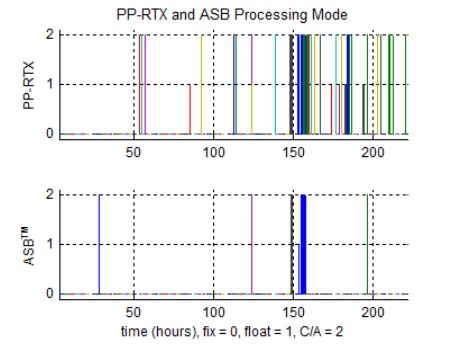
Figure 4: Processing Mode, PP-RTX and ASB™